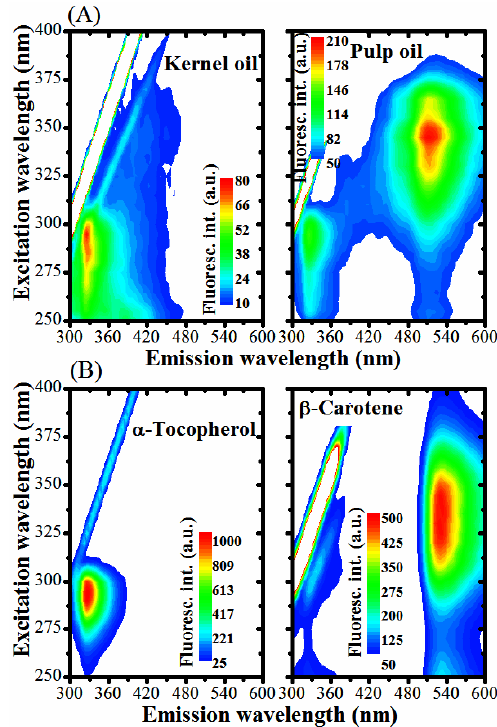
Figure 2. Excitation-emission contour maps of the ( A ) A. aculeata kernel and pulp oil and ( B ) α-Tocopherol and β-Carotene. Scatterings were not omitted. Samples diluted in hexane 1.5 w / v , α -Tocopherol 50 mg · L − 1 , and β -Carotene 3 mg · L − 1 .